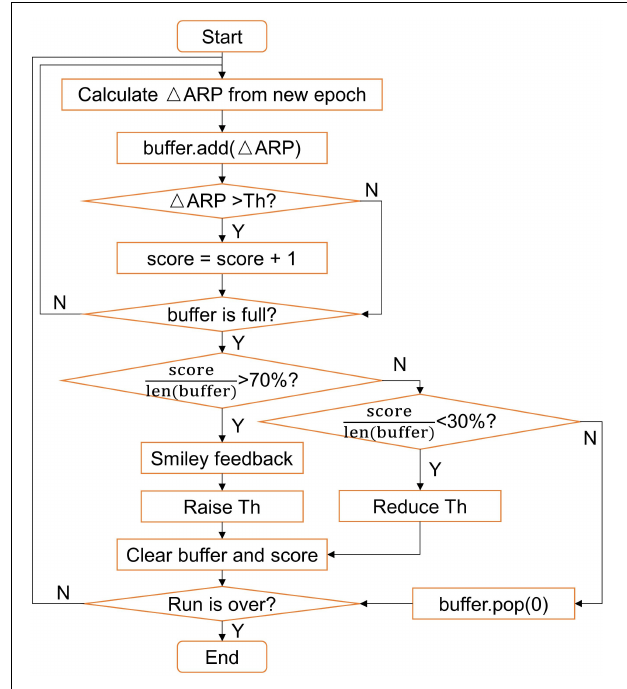
FIGURE 2 | Flow chart of the dynamic threshold